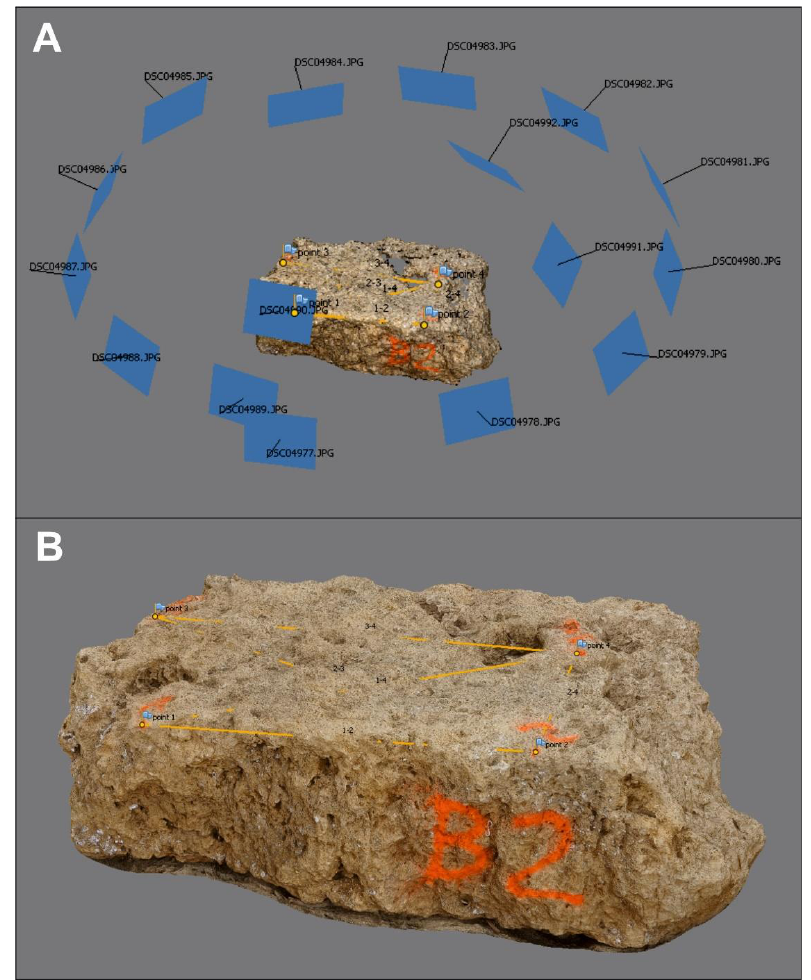
Figure 7. ( A ) Pictures (blue rectangles) and benchmarks (light blue flags) processed in Agisoft Photoscan Professional software version 1.4.0. ( B ) Three-dimensional model of boulder B2 reconstructed with Rhino 6.